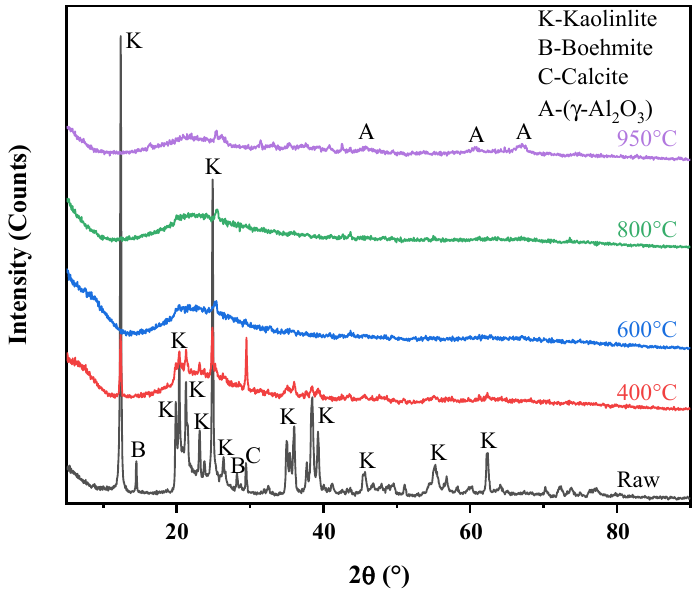
Figure 9. XRD patterns of calcined coal gangues at different temperatures.